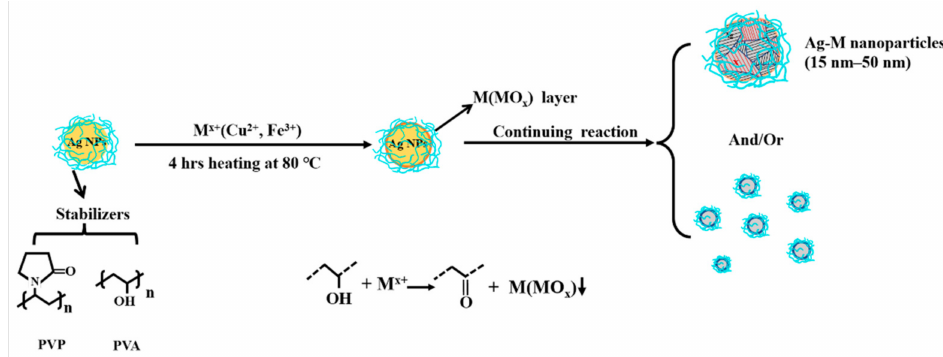
Figure 1. Schematic of the silver-based bimetal NA preparation using Ag NP catalysis.